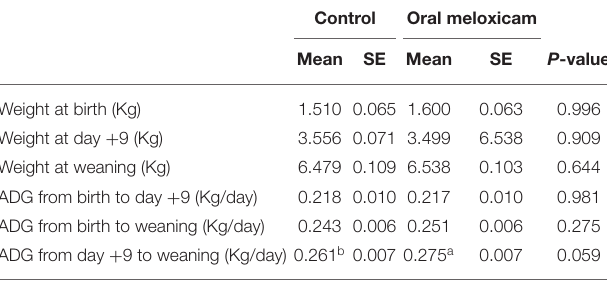
TABLE 2 | Mean and standard error (SE) of the piglet weight at birth, 9 days after farrowing (day + 9) and at weaning (day + 20) in Kilograms and the Average Daily Gain (ADG) of piglets from birth to day + 9 after farrowing, from birth to weaning and from day + 9 to weaning in Kilograms per day for 354 piglets regarding treatment (control vs. oral